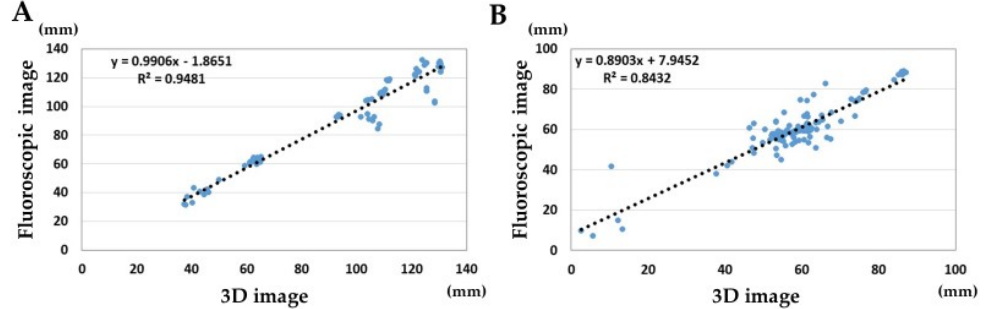
Figure 4. Correlations of marker distances between fluoroscopic image and 3D image. ( A ) QR code marker measurements. ( B ) Metal bead marker measurements. The blue dot indicate the measurements for the fluoroscopic and 3D images.